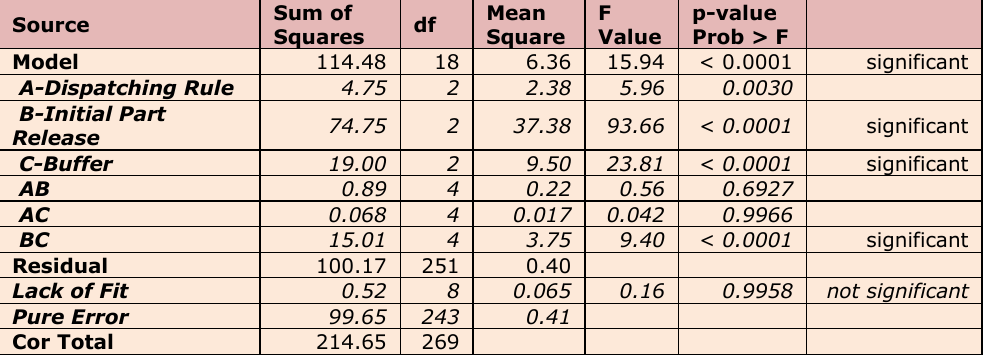
Table 9. ANOVA Analysis for machine